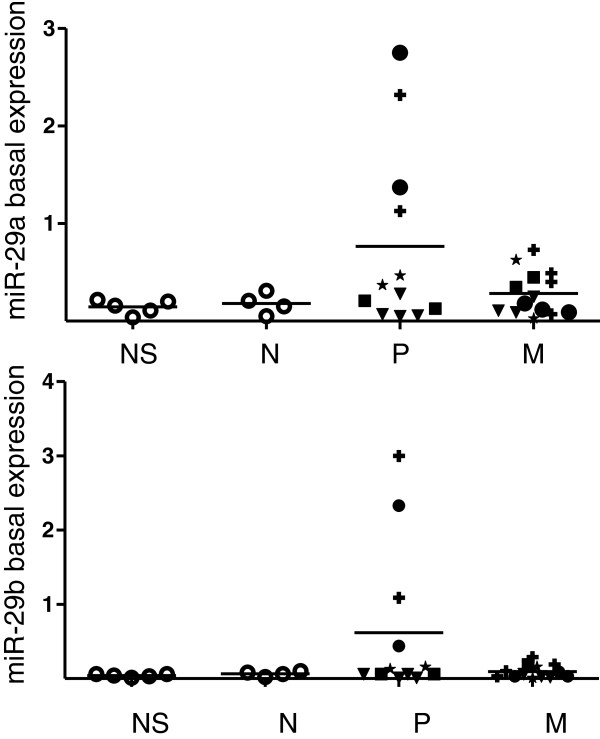
miR-29 expression in patient samples. Analysis of miR-29a (upper panel) and miR-29b (lower panel) basal expression of individual FFPE-patient samples from NS = normal skin, N = nevi, P = primary melanoma and M = metastatic melanoma. All graphs show 2-Δct with Δct= (ct (miR-29a/29b)– ct (RNU5A)). Primary and metastatic tumor samples were sorted according to patients (P1-5: P1-circles; P2-rectangles; P3-crosses; P4-triangles; P5-asterisks).